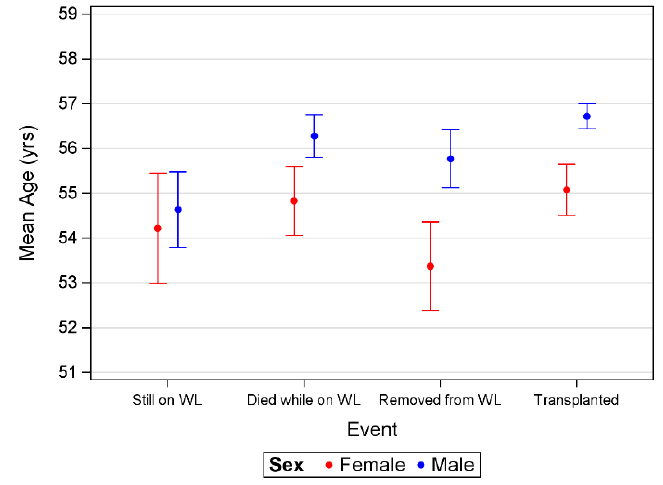
Figure 4. Mean age by sex for those patients still on waiting list (still on WL), those who died on waiting list (died while on WL), those removed from WL (removed from WL) and those trans- planted (transplanted).